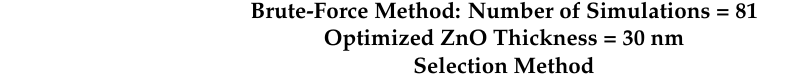
Table 1. Comparison results for ZnO single-layer optimization.